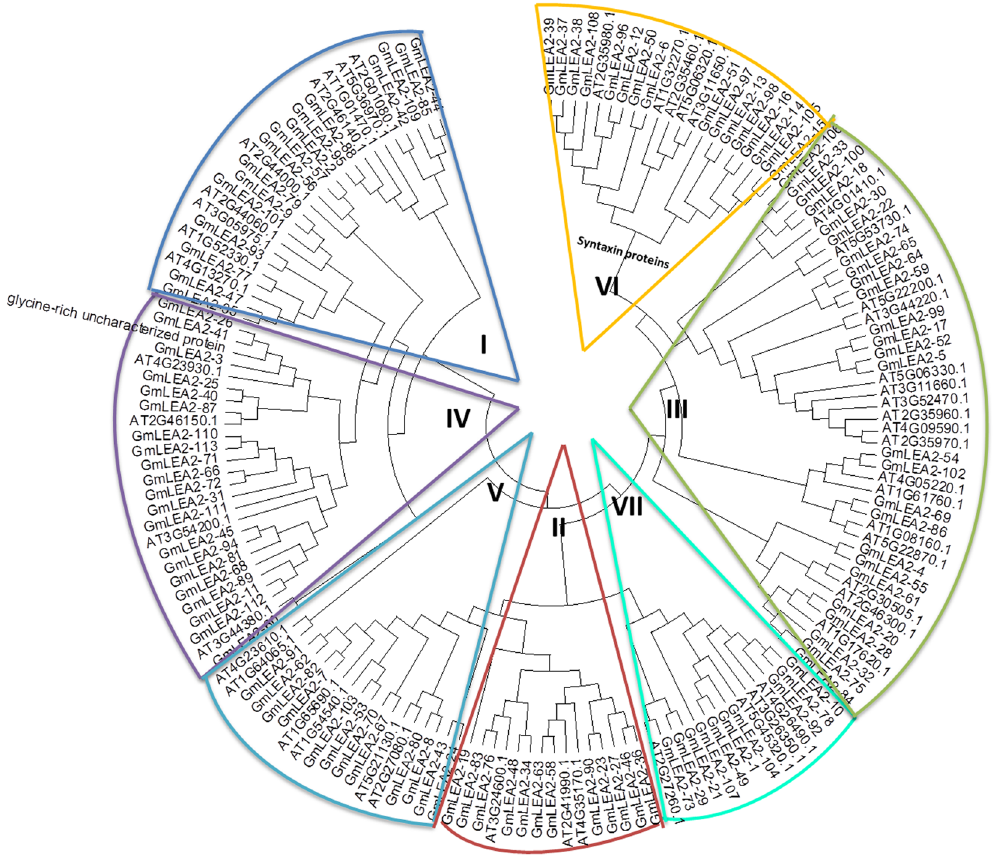
Figure 3. Phylogenetic tree of the amino acid sequences of LEA2 domains from soybean and Arabidopsis. The tree was conducted based on the LEA2 amino acid sequences using MEGA 6.0 by the neighbor-joining method with 1000 bootstrap